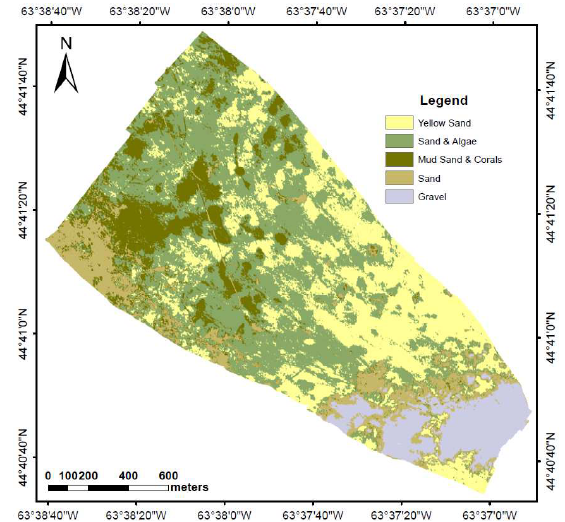
Figure 6: The classification result of Bedford Basin 2017 with five seabed classes. The quantitative evaluation (Table 2) indicated an overall accuracy rate of 99,9%.